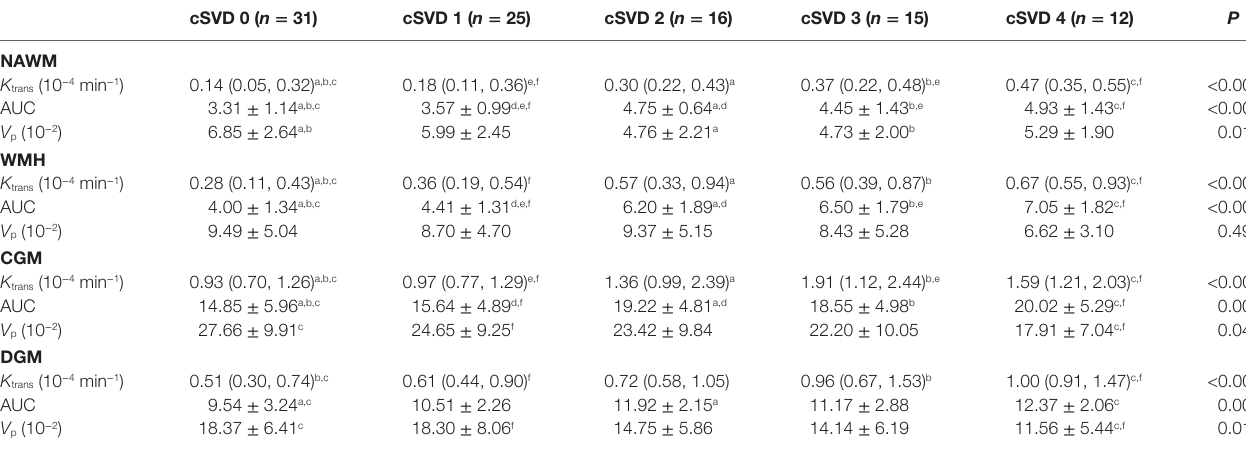
TaBle 2 | Leakage rate, area under the leakage curve, and fractional blood plasma volume of participants with different severity of total MRI cSVD burden.